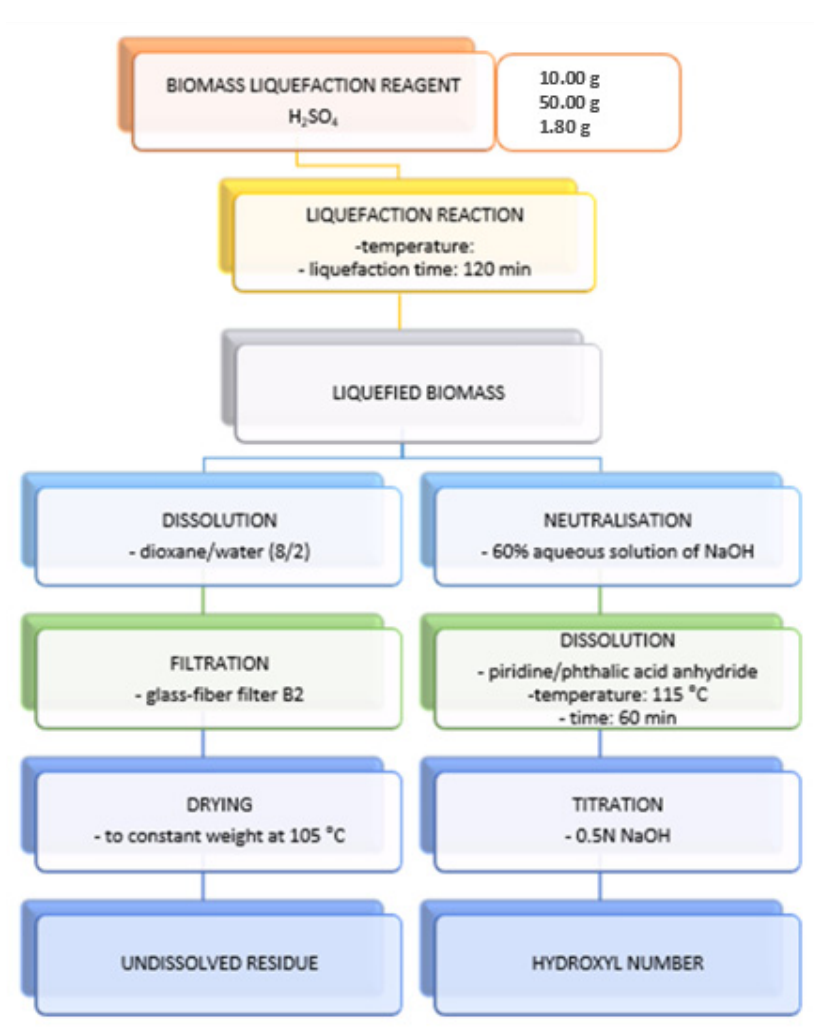
Figure 2. Liquefaction procedure and analytical methods for liquefied biomass characterization [34].